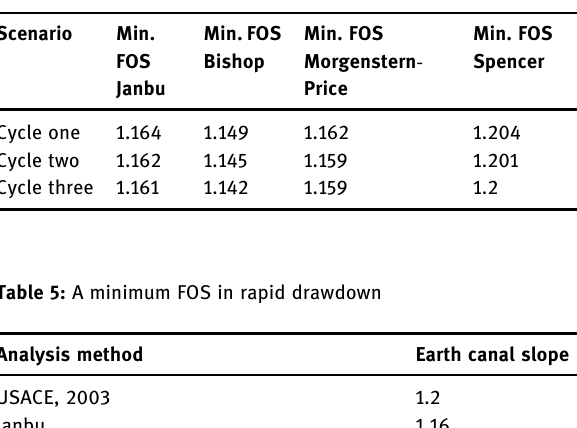
Figure 12: Speci fi c energy for a given unit discharge.